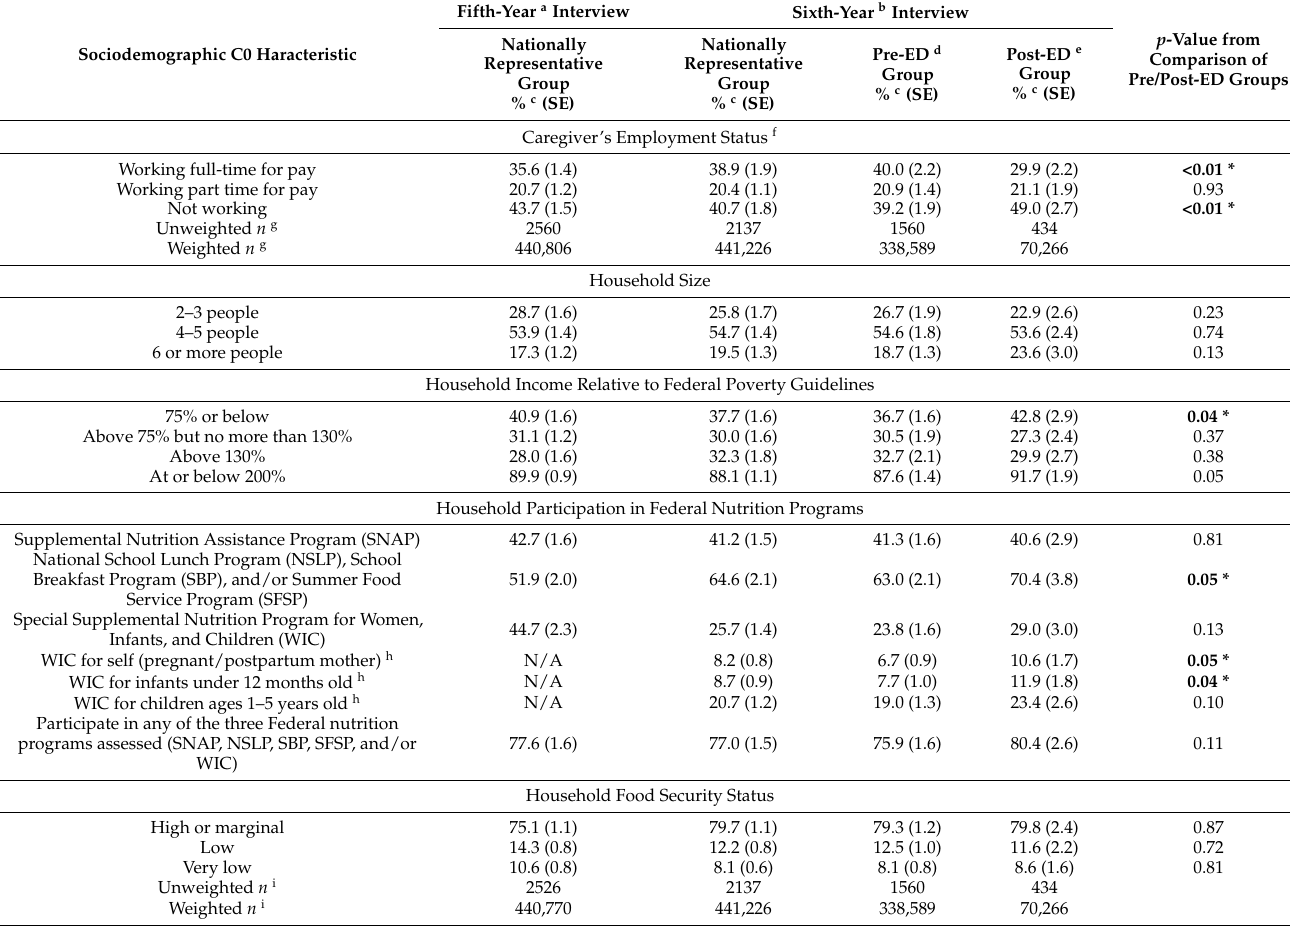
Table 1. Select sociodemographic characteristics of respondents during the children’s fifth and sixth